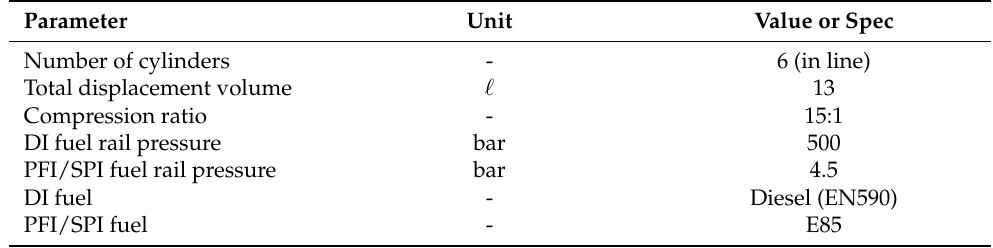
Table 2. Dual fuel RCCI engine